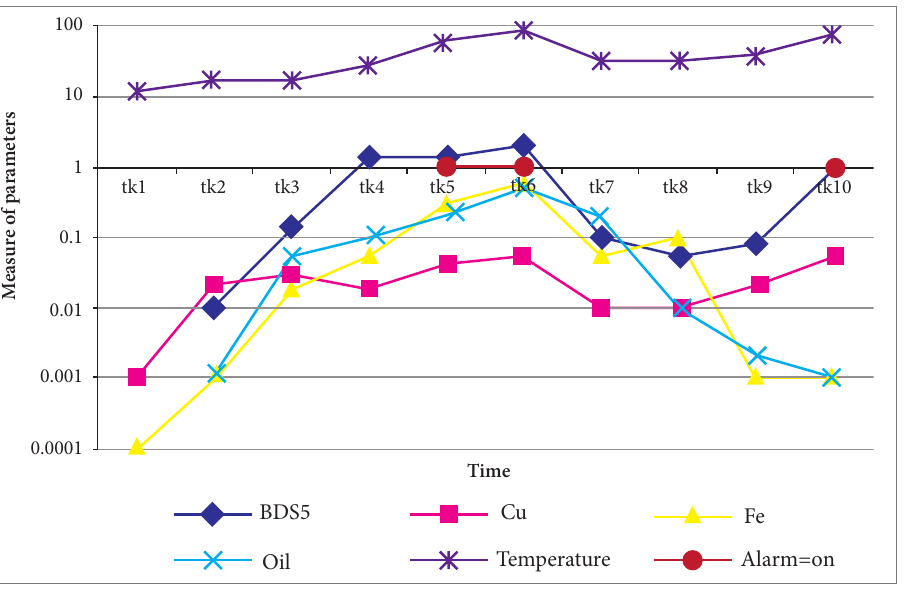
Fig. 4. An example of case study of representation and recognition of physical parameters of temporal information management in